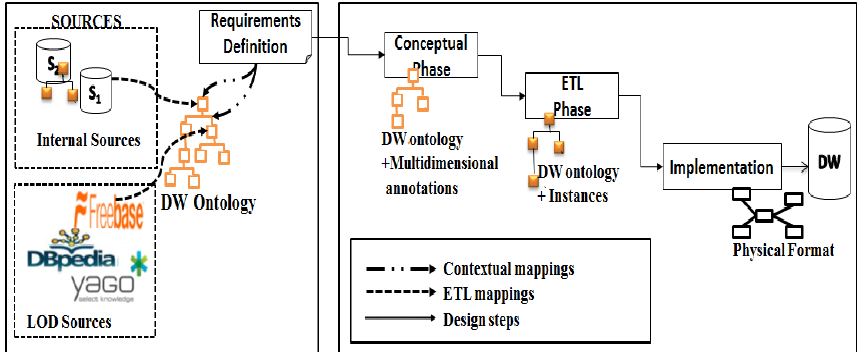
Figure 1. Data warehouse ( DW ) design process. ETL: extract–transform–load; LOD : linked open